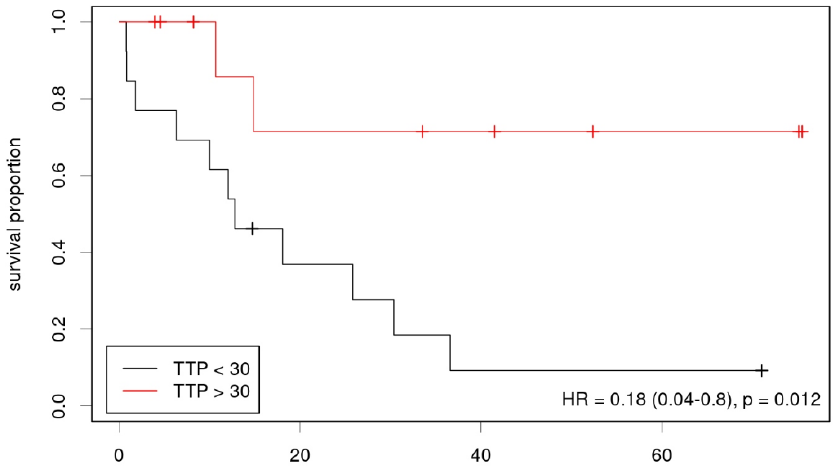
Figure 5. Kaplan–Meier plot showing low- and high-risk groups according to dynamic FET-PET (TTP).